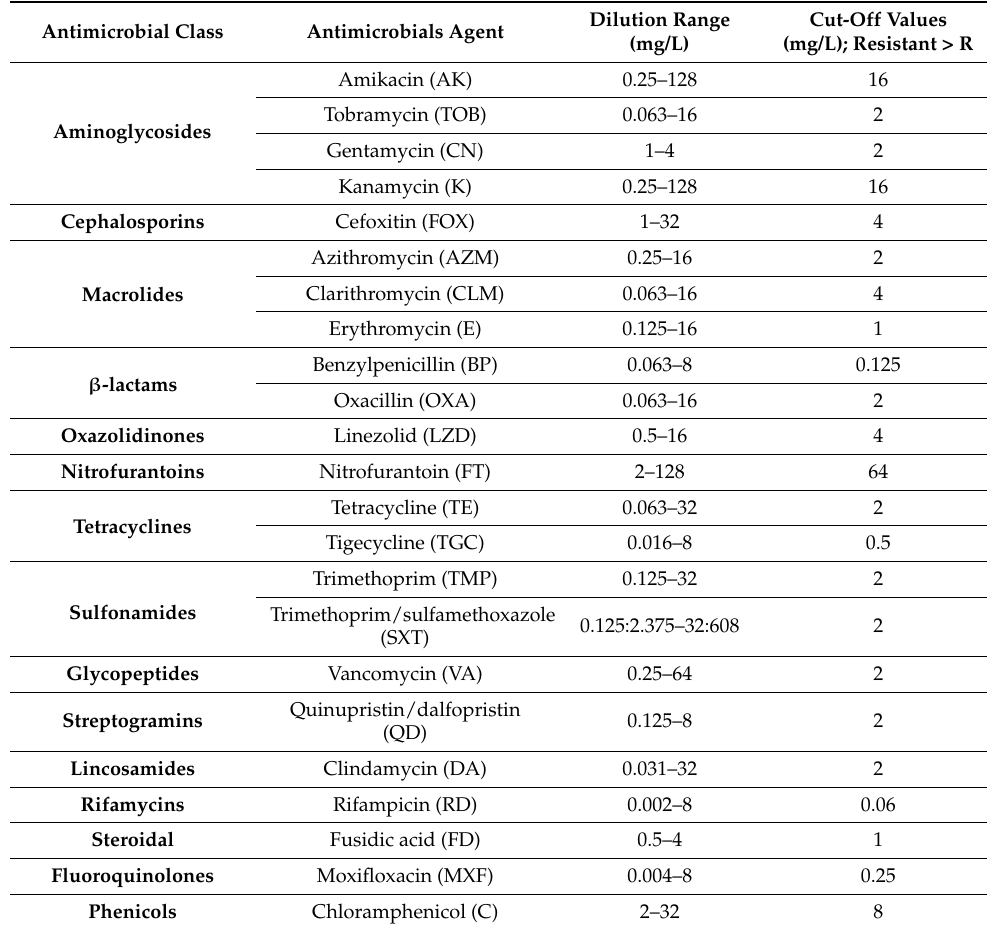
Table 5. Antimicrobials, dilution ranges, and cut-off values used for minimum inhibitory concentra- tion (MIC) determination in S. aureus